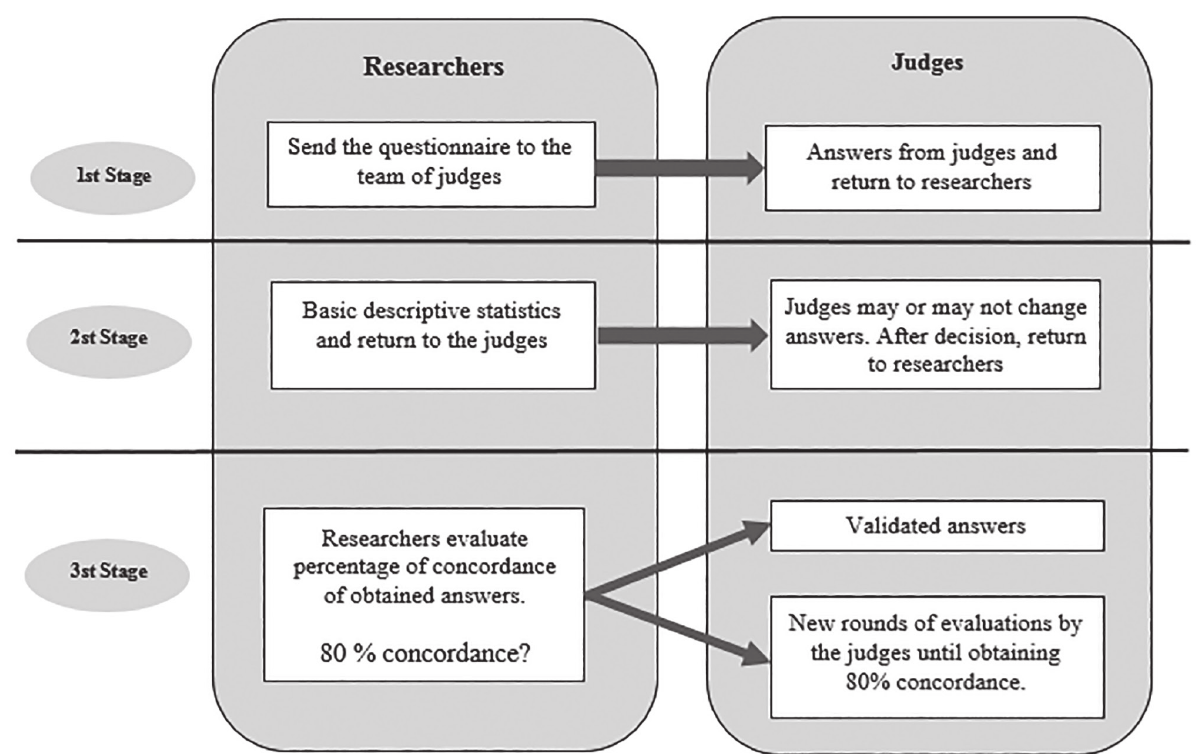
FIGURE 1 - Description of the evaluation stages of the judges in the Delphi technique. Source: Prepared by the author. Adapted from Sousa and Turrini, 2012 (16). Legend: DM2 - Diabetes Mellitus Type